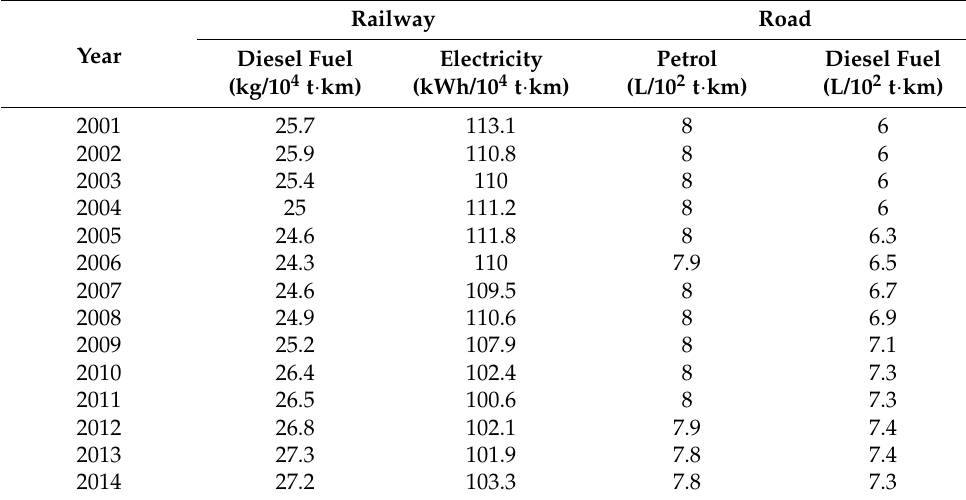
Table 4. Energy efficiency of different modes of transportation.